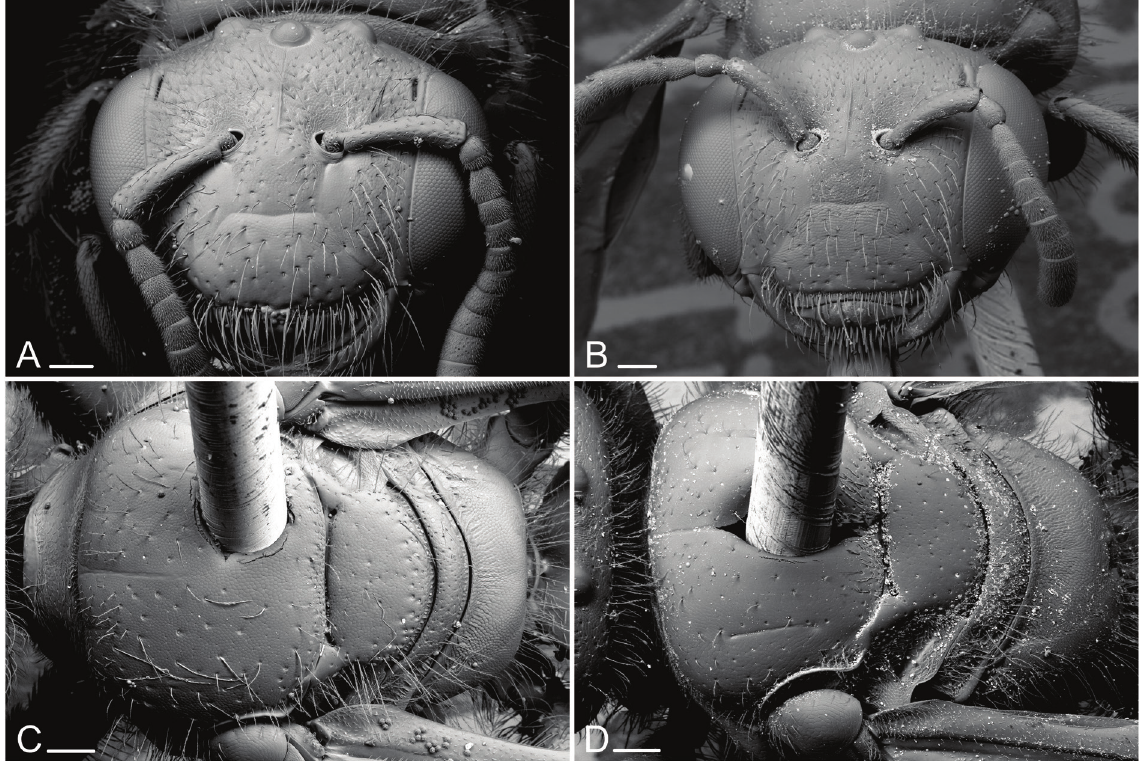
Fig. 4. Scrapter albitarsis (Friese, 1909), ♀, all SEM. A . Head. B . Head. C . Thorax (dorsal view). D . Thorax (dorsal view). Scale bars: 0.1